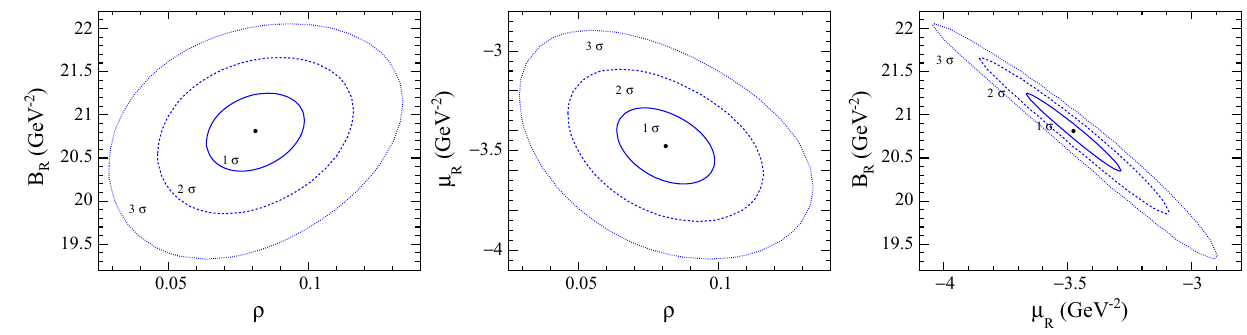
Fig. 3 Correlation maps of the parameters of the real part for T8 measurements under Condition (III)). The flattening behavior of the curves relating ( B R ,ρ) and (μ R ,ρ) show the weak correlation between parameters. The narrow areas in ( B R ,μ R ) indicate the strong correlation between these two parameters